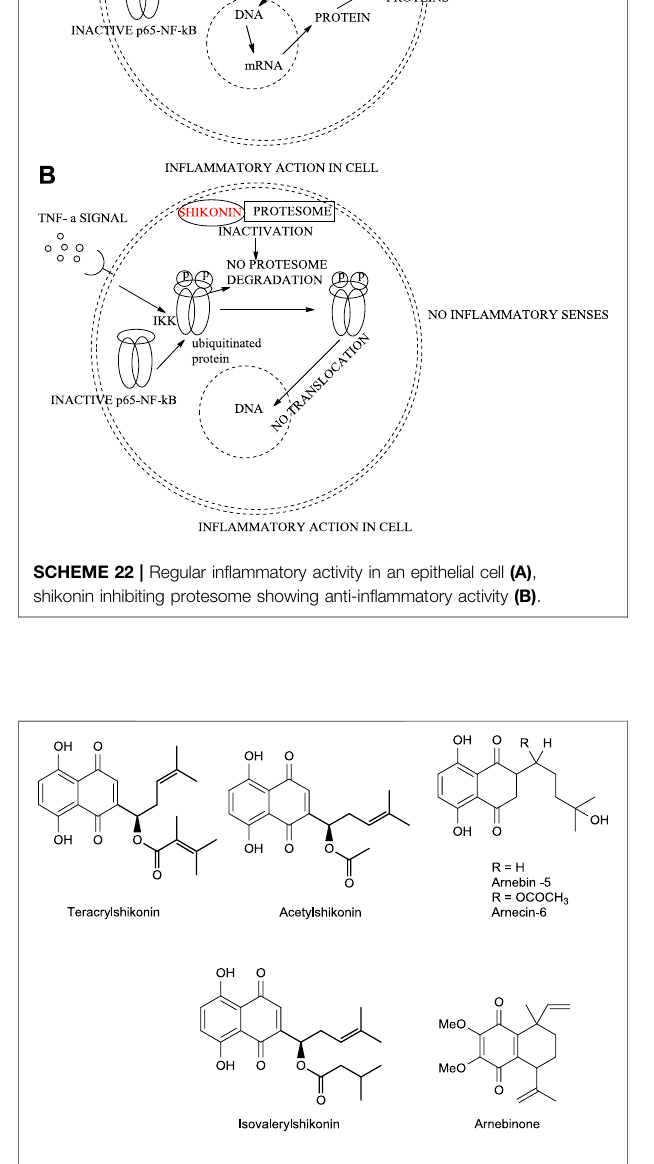
Frontiers in Pharmacology |